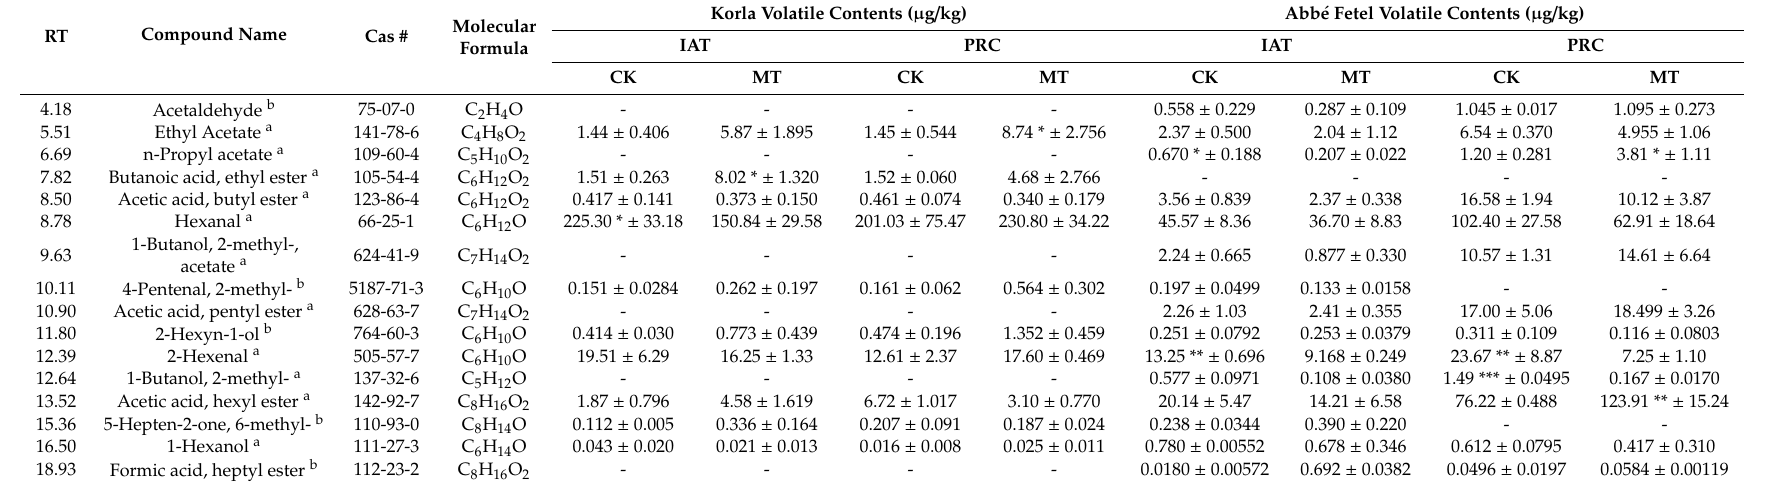
Table 1. E ff ects of melatonin on content of volatile compounds ( µ g / kg) in postharvest ‘Korla’ and ‘Abb é Fetel’